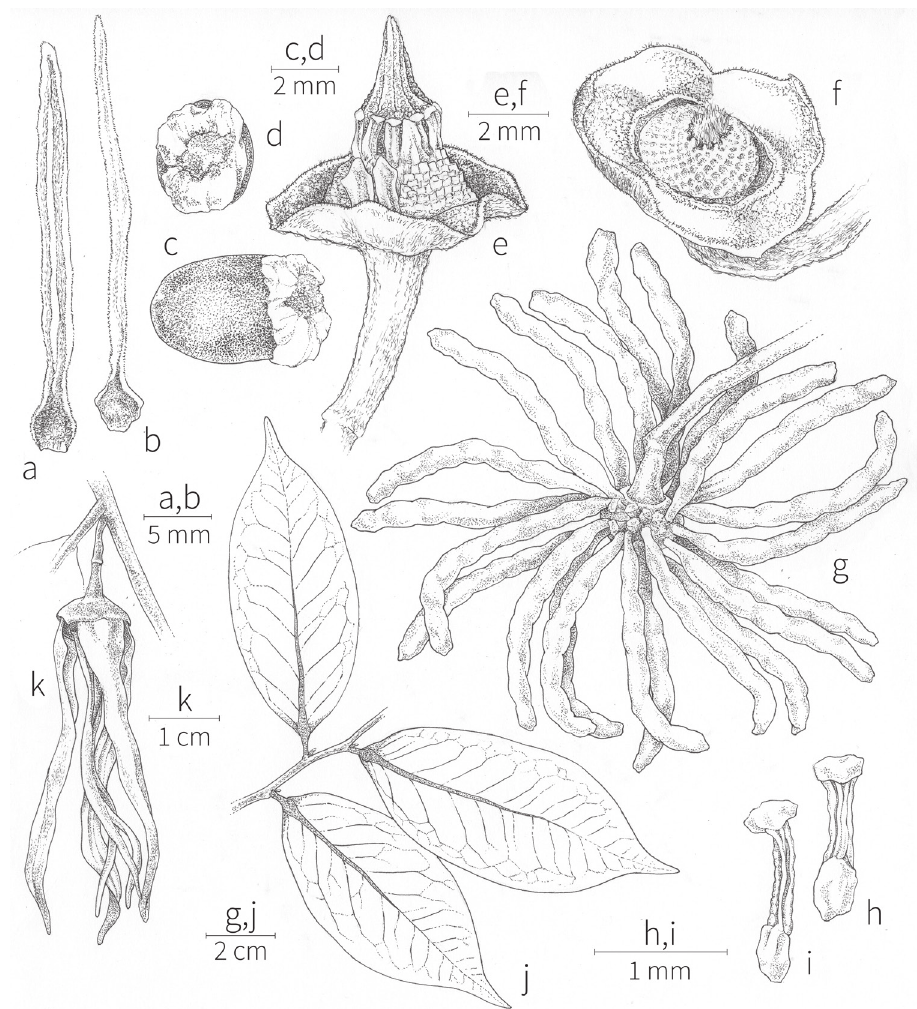
Figure 16. Xylopia aethiopica . A Outer petal, adaxial view B Inner petal, adaxial view C Seed, side view D Seed, view of micropylar end E Flower with petals and most stamens removed to show gynoecium, in- ner staminodes, staminal cone, two outer staminodes, and sepals F Staminal cone G Fruit. H, I Stamens, abaxial view J Leaves K Flower, side view. A, B, E, H, I from McPherson 15168 (MO) C, D from Wilks WIL 922 (WAG) F, G, K from Wieringa et al. 3031 (WAG), J from Nkongmeneck 399 (P). obtuse, rounded, or truncate; buds linear-oblong, rarely oblong, apex obtuse to acute, often curved. Sepals erect to slightly spreading at anthesis, 1/4–2/3-connate, 2.2–4.1 mm long, (3.2–) 4.4–6 mm wide, coriaceous, semicircular to broadly triangular, apex acute to rounded, sparsely pubescent to glabrate abaxially. Petals greenish white to yellow, the inner petals sometimes with a tinge of purple at the base in vivo ; outer petals spreading but with the apices incurved at anthesis, (11.6–20.9) 28–64